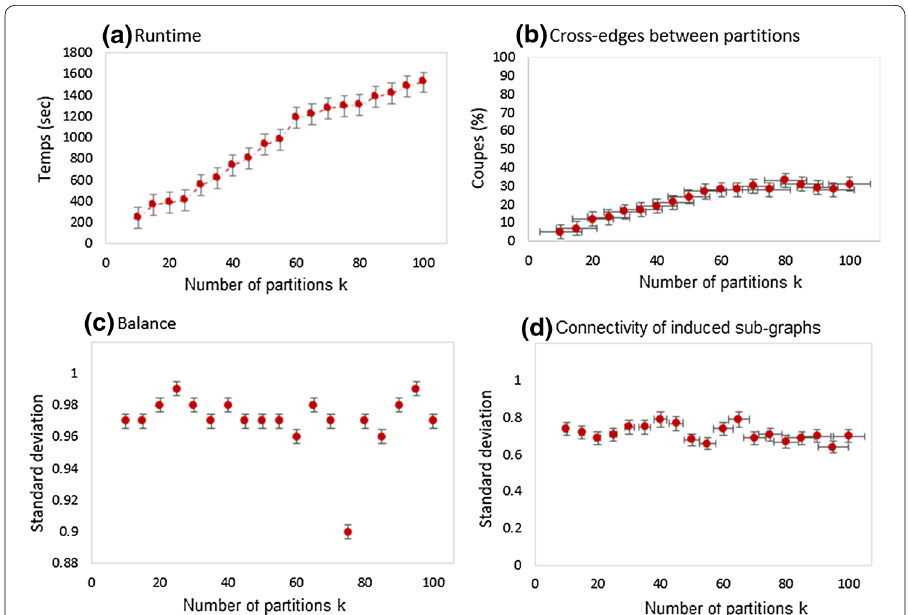
Fig. 15 DPHV behavior based on the number of partition